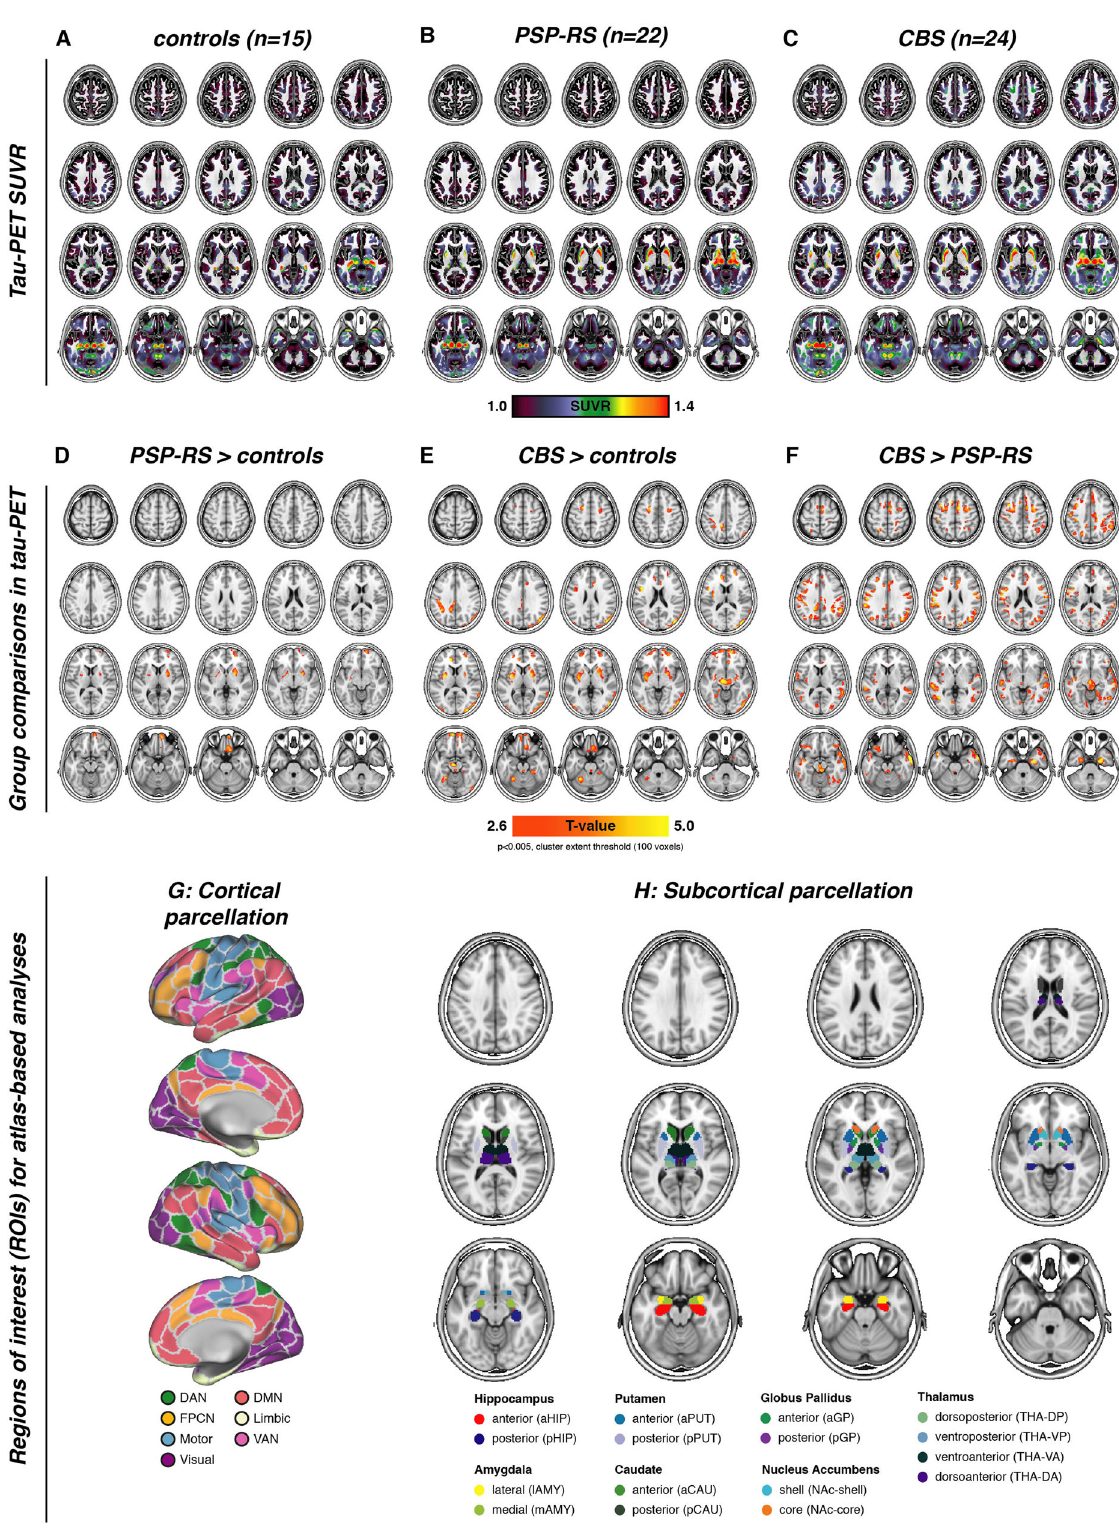
Fig. 1 PI-2620 tau-PET uptake patterns in controls/patients and brain parcellation scheme. Group-average maps of tau-PET SUVRs (i.e., intensity normalized to the inferior cerebellar gray) for controls ( A ), PSP-RS ( B ), and CBS patients ( C ). Voxel-wise group comparisons were conducted to compare tau-PET SUVRs between PSP-RS vs. controls ( D ), CBS vs. controls ( E ), and CBS vs. PSP-RS ( F ), at a voxel threshold of p < 0.005 with a cluster size of at least 100 spatially contiguous voxels. Illustration of the 200 ROI cortical ( G ) and 32 ROI subcortical ( H ) brain atlases that were used for all tau-PET vs. connectivity